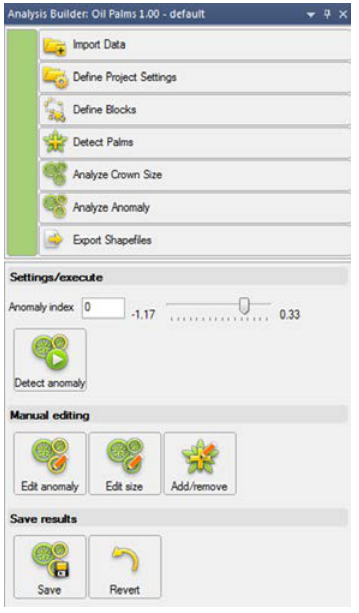
Figure 9: Guided workflow concept of the application. 3.2.5 Export: The derived data consists of 1.) the region of interest (ROI) statistics (including number of palm trees per block (defined by block identification number = block-ID), area, statistical summary of individual tree attributes per block), 2.) Tree positions (including palm tree size, height, crown diameter, anomaly status, block-ID), 3.) Tree crowns (including palm tree size, height, crown diameter, anomaly status, block-